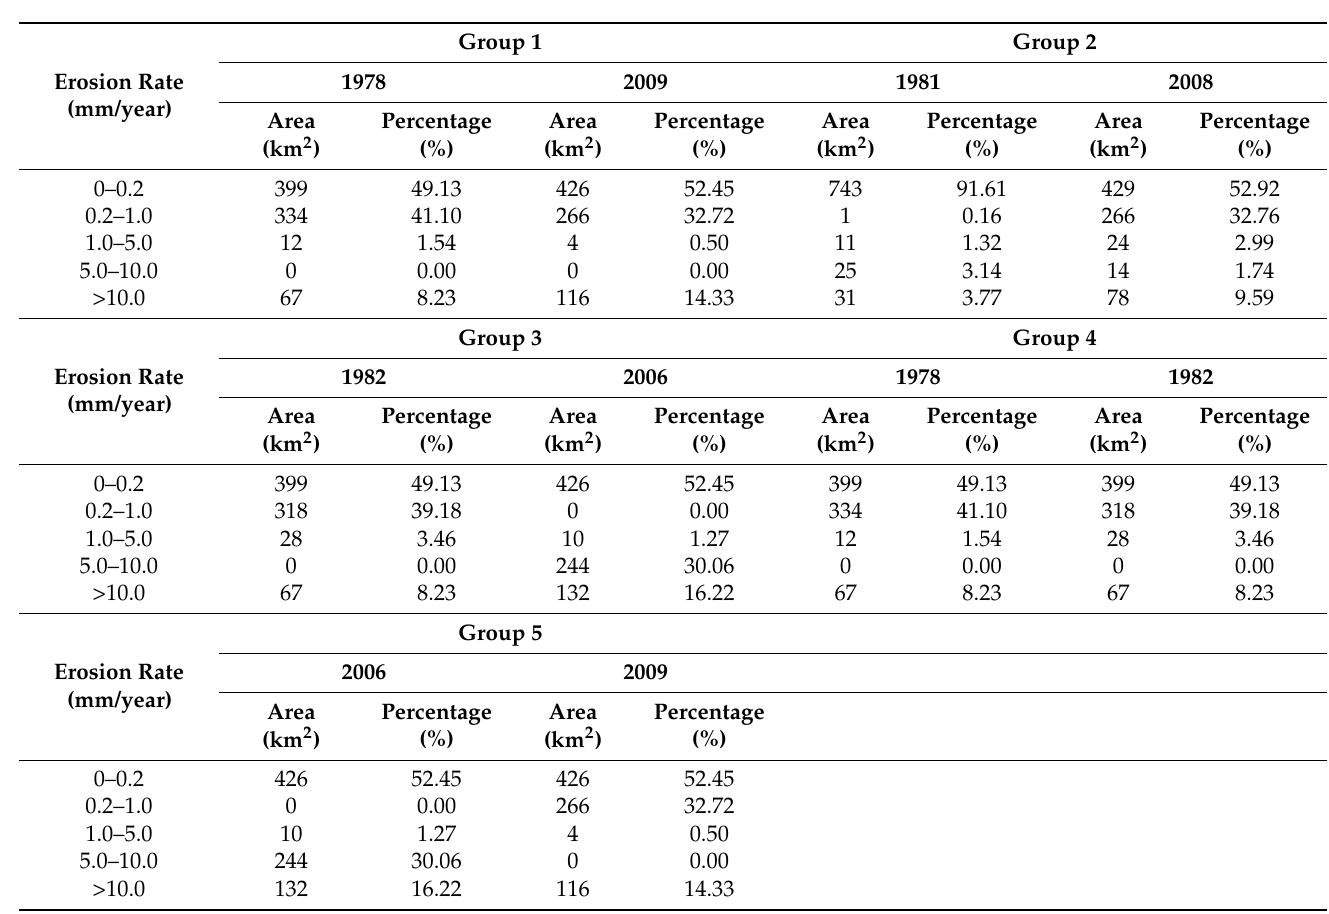
Table 5. Area of predicted annual erosion rate classes for Groups 1~5.